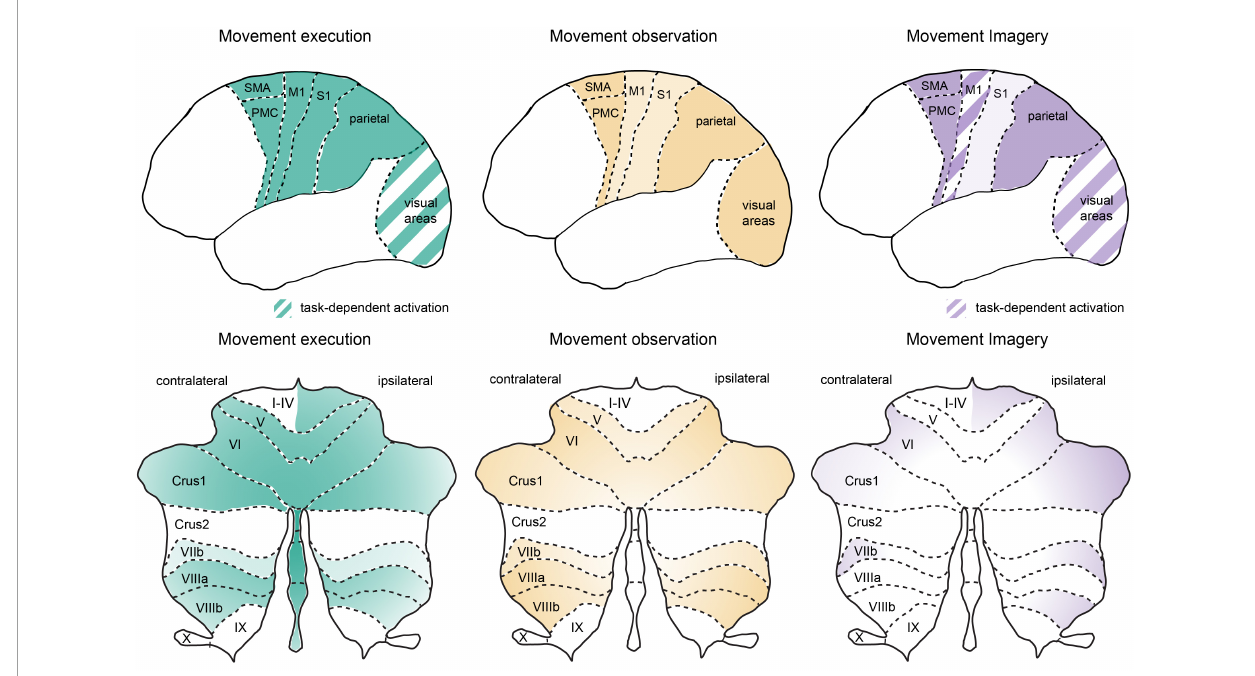
FIGURE1 Similar global networks but different patterns of activation in cortical and cerebellar regions during movement execution, observation, and imagery. Schematic representation of cortical (upper panel) and cerebellar (lower panel) activation patterns during movement execution (left) , action observation (middle) and motor imagery (right) . Stronger relative activation is indicated by darker colors and striped regions indicate areas with highly task-dependent activation patterns. Overview of the activation patterns were schematized based on a summary of neuroimaging studies in humans as discussed in the text. Note that here we focus on premotor, motor, parietal, and sensory cortical networks as well as the cerebellum. An important role for lateral prefrontal cortex has been reviewed previously (see Rozzi and Fogassi, 2017) and the basal ganglia also plays an important role in cognitive-motor interactions (e.g., Yágüez et al., 1999; see also Leisman et al., 2014). M1, primary motor cortex; stocktickerPMC, pre-motor cortex; S1, primary somatosensory cortex; SMA, supplementary motor area, note SMA as indicated here also includes preSMA; visual areas, represent striate and extrastriate cortical regions, see text for details; cerebellar lobules I-X, crus 1, and crus 2 are indicated on a representation of the unfolded cerebellar